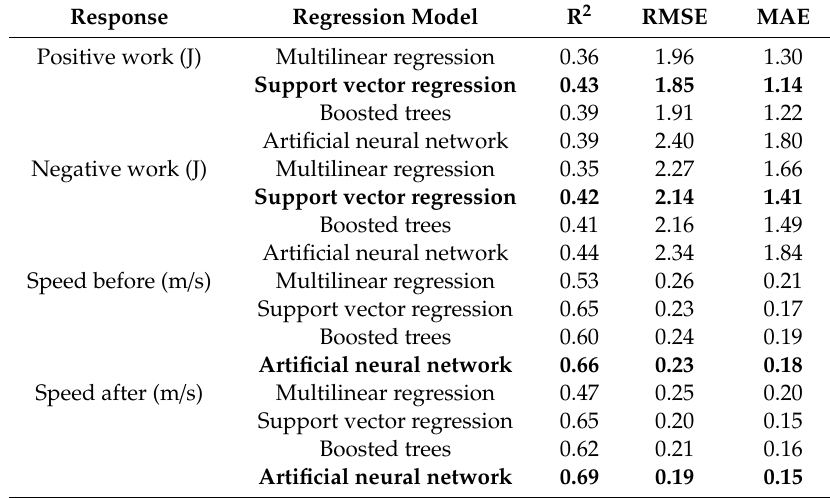
Table 2. Performance of regression models. In bold, the best model for each response, in terms of root mean square error